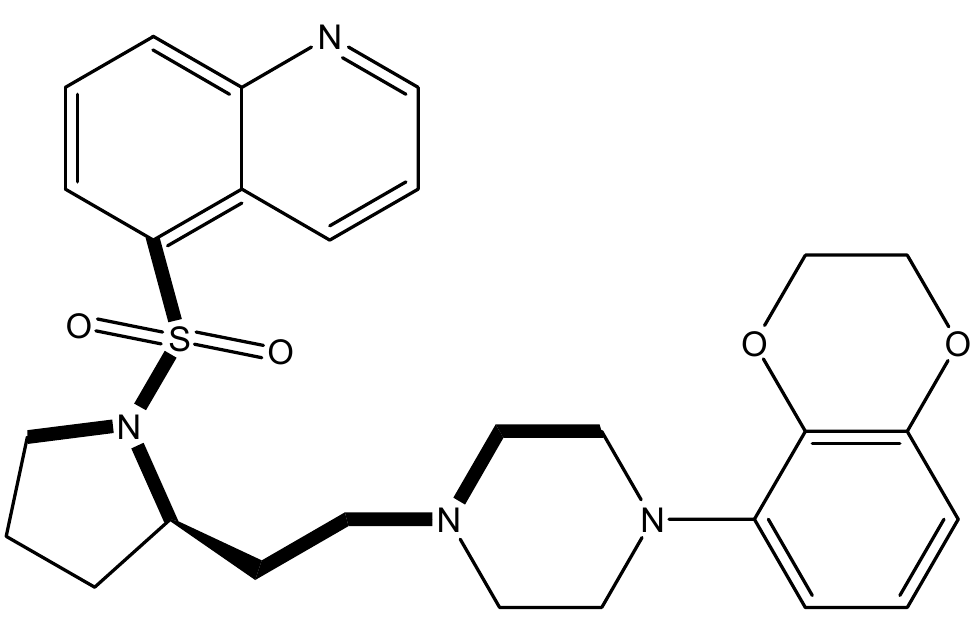
Figure 1. The alignment of all compounds in the dataset, compound 43 was used as the template and the common substructure (shown in bold) for the alignment of all compounds. the common substructure (shown in bold) for the alignment of all